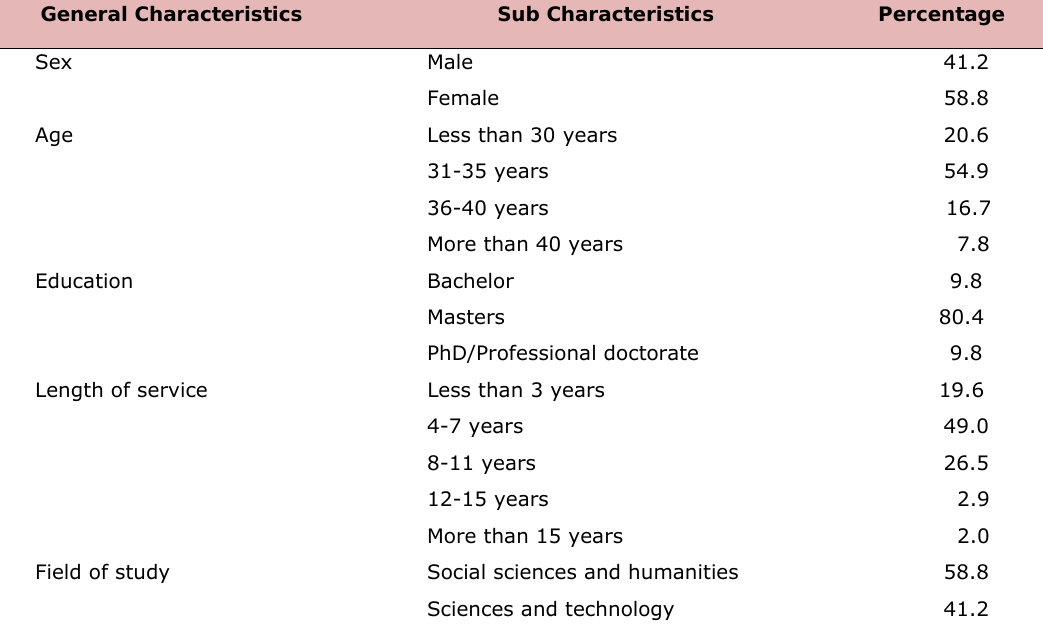
Table 1. “Profile of respondents (N =